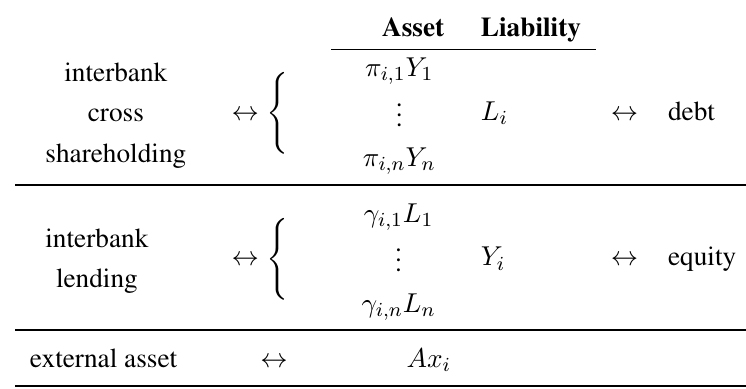
Table 4. Balance sheet of institution i in Gouriéroux et al.